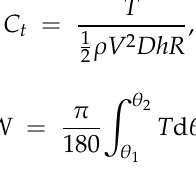
Table 2. Mesh size and quantity.